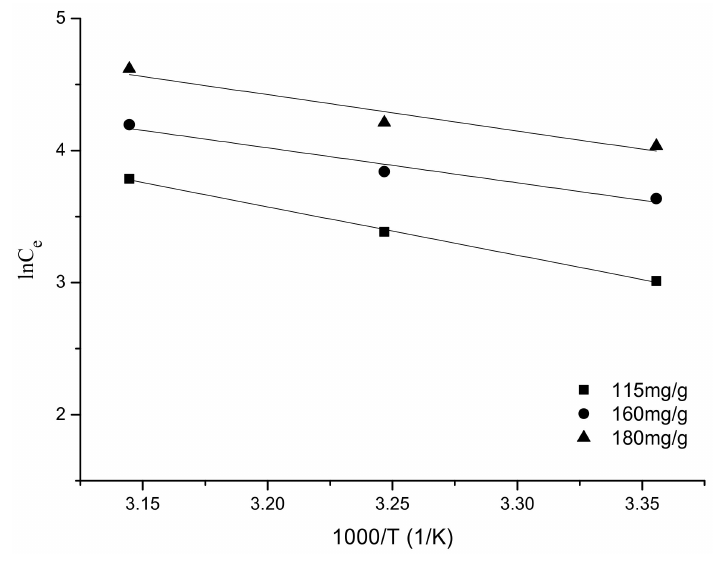
Figure 5. Linear relationship between lnQ e and 1 / T. Table 3. Thermodynamic parameters for the adsorption of amygdalin by XDA-1